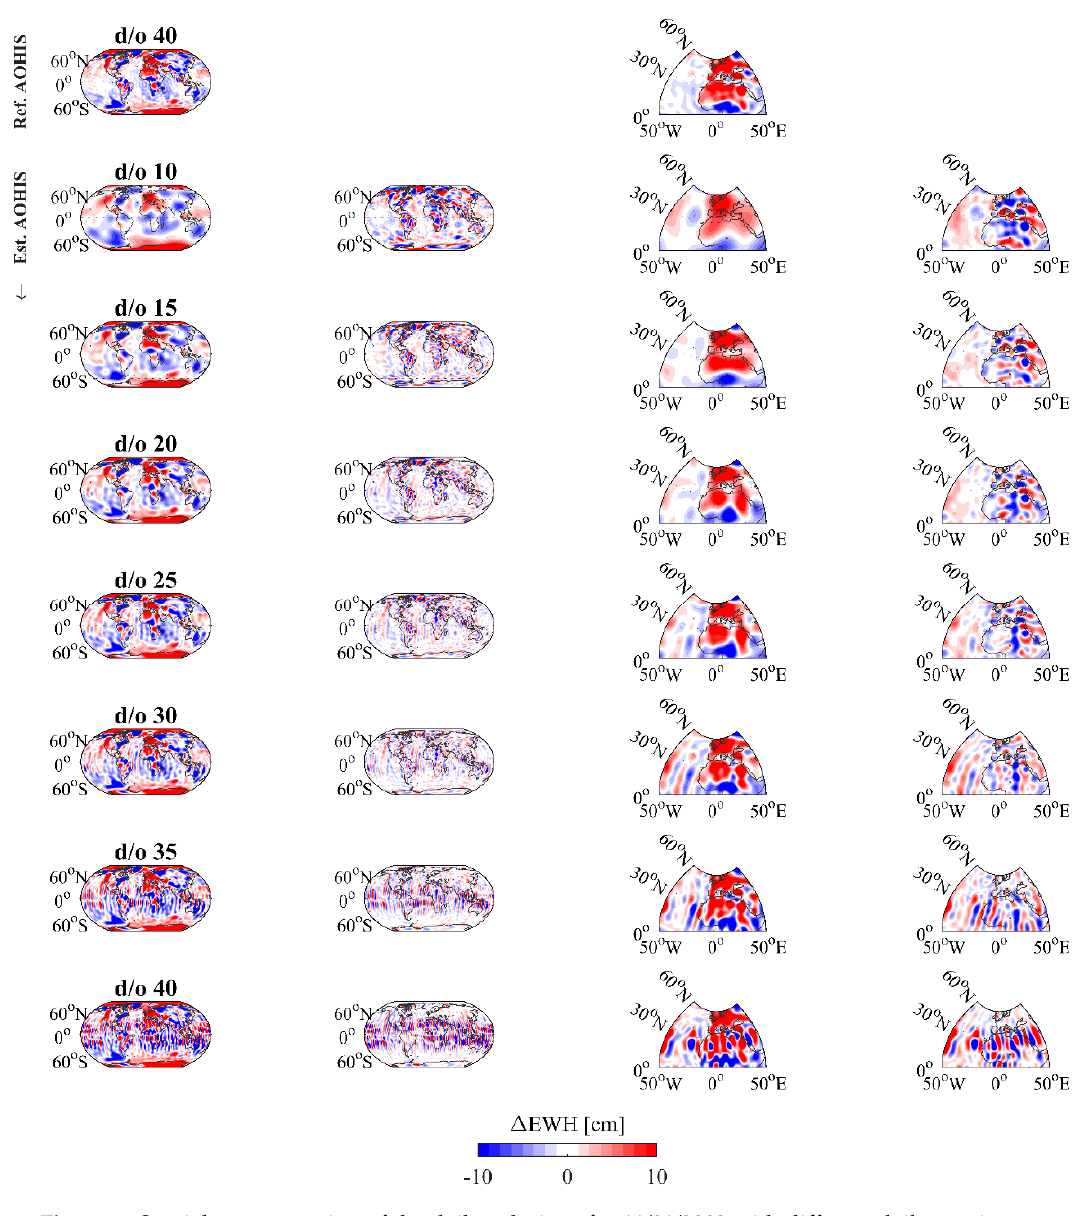
Figure 9. Spatial representation of the daily solutions for 11/01/2002 with different daily maximum degree based on scenario 3pii,p per row. Columns 1 and 3 show the estimated gravity field. Columns 2 and 4 show the difference to the reference atmosphere, ocean, hydrology, ice, and solid Earth (AOHIS) (d/o 40), such including the omission error. Columns 3 and 4 show a snapshot of the Northern hemisphere.